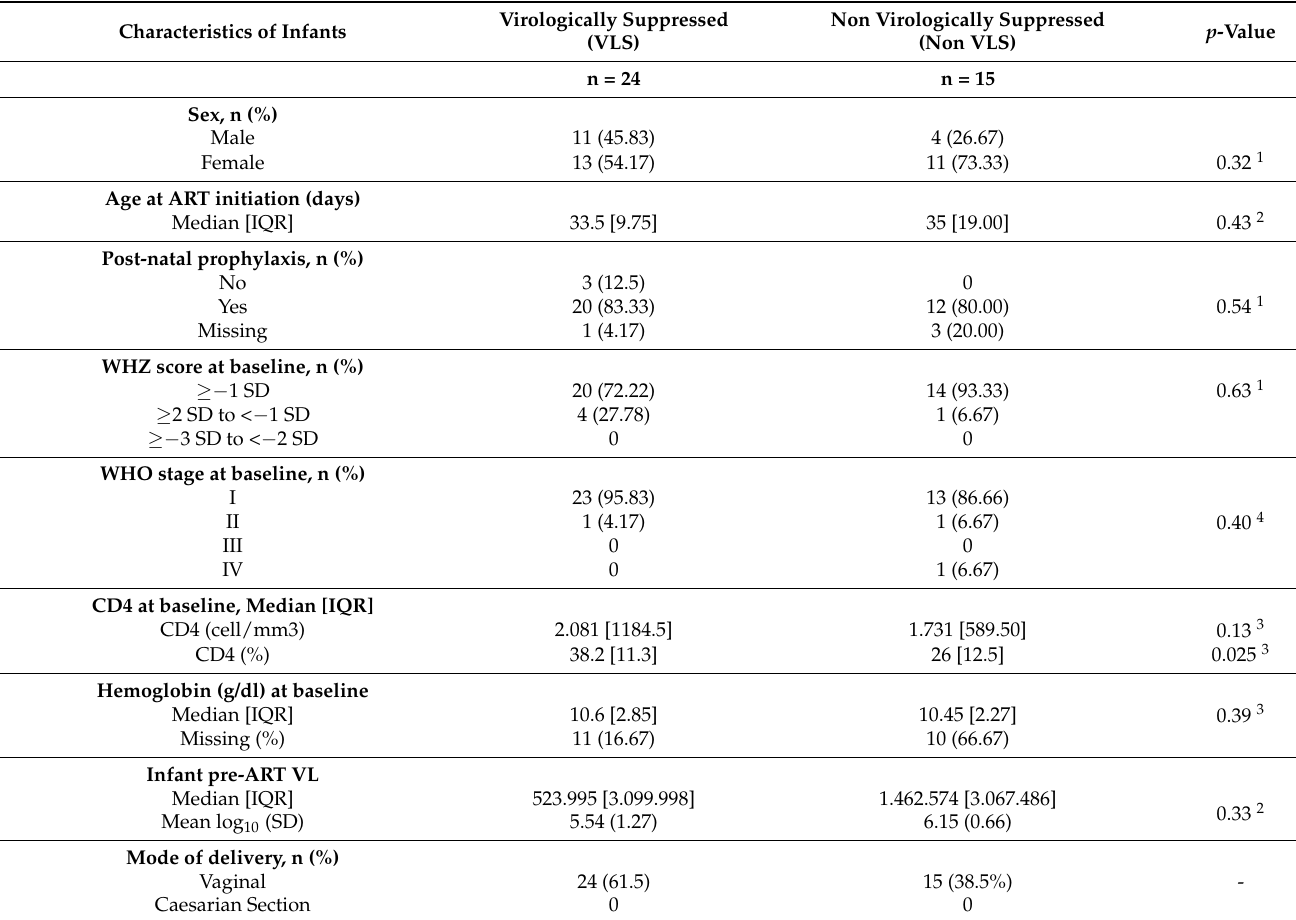
Figure 4. Cumulative probability of re-suppression (VL ≤ 400 copies/mL) among infants who had viral rebound > 1000 copies/mL). Note. The area in blue represents the 95% CI. Table 2. Characteristics of infants who reached viral suppression ≤ 400 copies/mL (VLS) and who did not reach viral suppression (Non